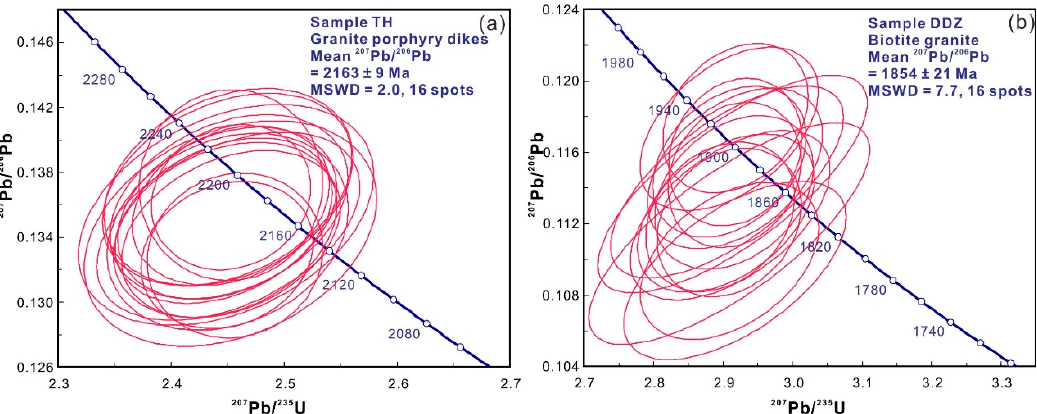
Figure 5. Concordia diagrams of LA–ICP–MS zircon U-Pb for Paleoproterozoic igneous rock in the Qingchengzi district, ( a ) sample TH, ( b ) sample DDZ.